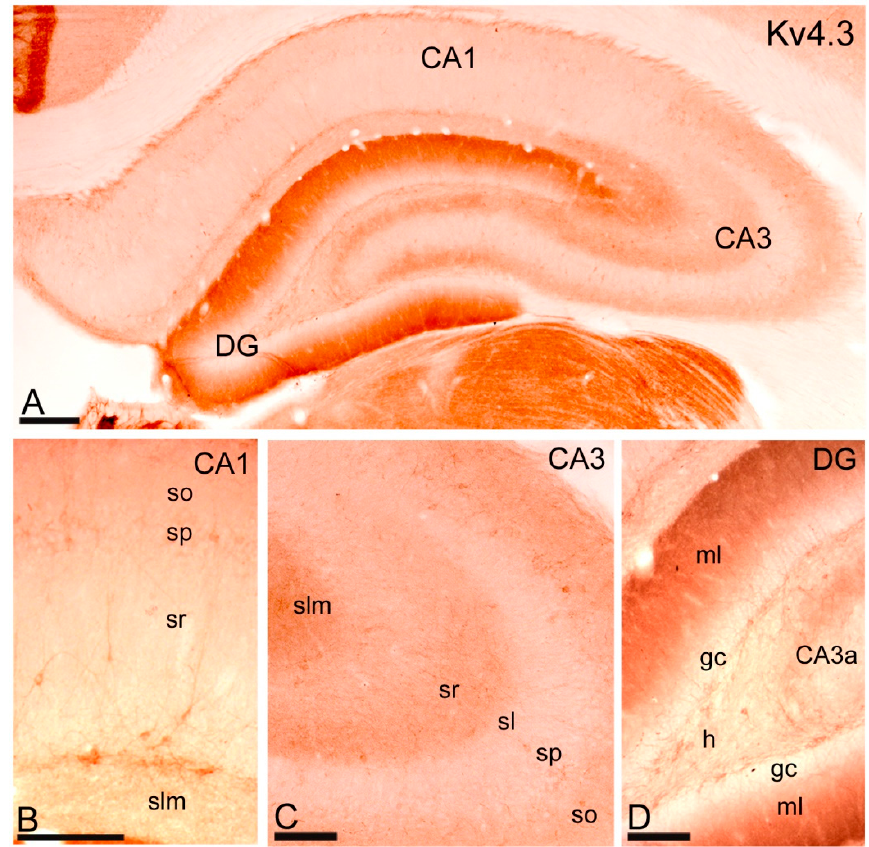
Figure 6. Distribution of immunoreactivity for Kv4.3 in the hippocampus. ( A ) Immunoreactivity for Kv4.3 was widely distributed in the hippocampus although cellular distribution varied in a subfield-dependent manner; ( B ) In the CA1 region, immunoreactivity for Kv4.3 was observed exclusively in the soma and dendrites of interneurons distributed throughout the strata oriens (so), pyramidale (sp), radiatum (sr) and lacunosum-moleculare (slm); ( C ) In the CA3 region, immunolabelling for Kv4.3 was detected along the soma and dendrites of interneurons scattered throughout the strata oriens (so), pyramidale (sp), radiatum (sr) and lacunosum-moleculare (slm). In addition, strong neuropilar staining that indicate expression in pyramidal cells was observed in in strata oriens (so), radiatum (sr) and lacunosum-moleculare (slm) with a weaker labelling in the stratum lucidum (sl), but very weak in the stratum pyramidale (sp); ( D ) In the dentate gyrus (DG), immunolabelling for Kv4.3 was strong in the neuropil of the molecular layer (mL) and weak in the hilus (h), and also strong in somata and dendrites of scattered interneurons. The granule cell layer of the dentate gyrus showed very weak immunolabelling for Kv4.3. Scale bars: A , 200 µm; B – D , 100 µm.